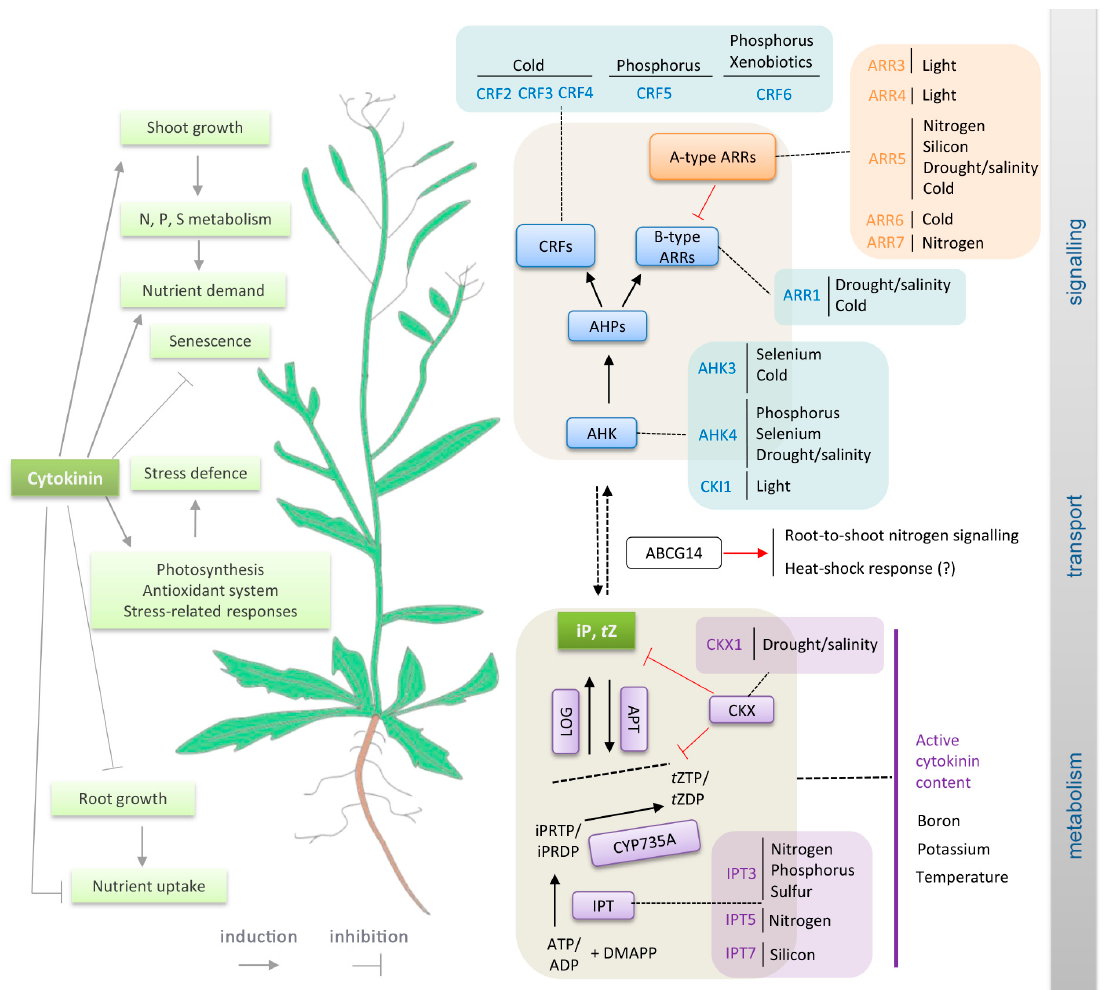
Figure 1. Crosstalk between abiotic stress signals and cytokinin. Summary of interactive points between cytokinin metabolism and signalling pathways (as currently modelled in Arabidopsis [5]) and abiotic stress response pathways. See corresponding sections of the text for details and references.